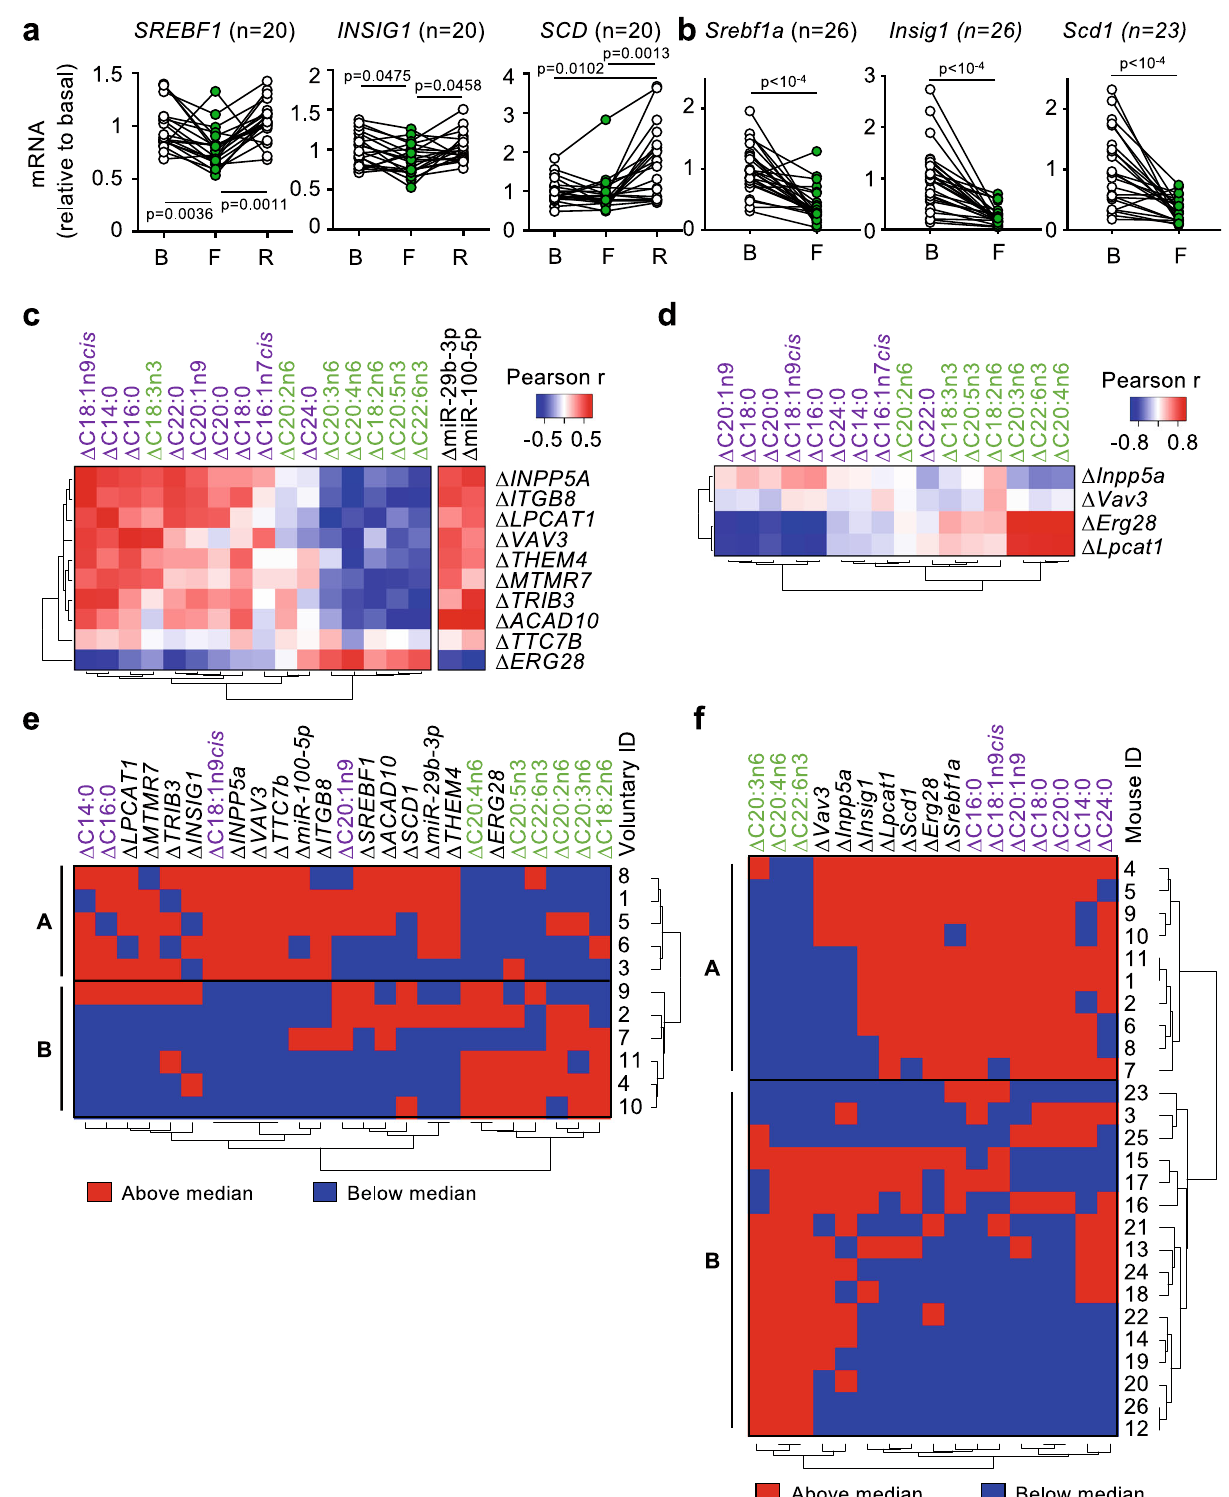
Fig. 4 | Gene expression in peripheral blood mononucleated cells (PBMCs) during short-term fasting. a , b Total RNA from PBMCs isolated from humanvolunteers( a ) or mice ( b ) atthe indicated time points (Bbasal, F fasting, R refeeding) was analyzed for the expression of the indicated lipid metabolism genes. c , d HeatmapsdepictingthePearsoncorrelationrcoef fi cientsinhumans( c ) ormice( d )betweenthe changes withfasting of erythrocytemembrane fattyacids and/or circulating miRNAs, and the changes in mRNA expression of the indicated genes identi fi ed in the PBMC RNAseq experiment. e , f Heatmaps depicting each individual, represented by a number next to each panel, and its position with